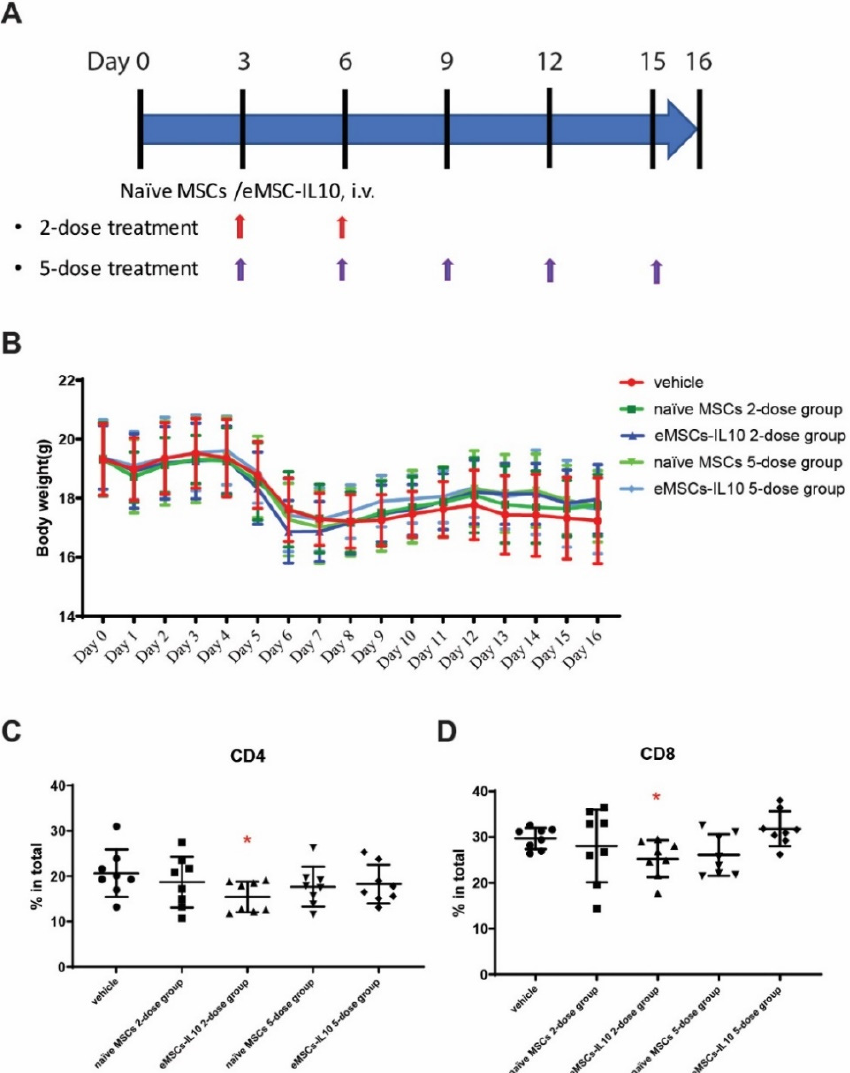
Figure 5. Engineered MSCs-IL10 significantly inhibited CD4+ and CD8+ T cells proliferation in the aGvHD mouse model. ( A ) Flow diagram of naïve MSCs and eMSCs-IL10 administration. In this experiment, two regimens were applied. For the two-dose treatment, MSCs were administered on Day 3 and Day 6. For the five-dose treatment, MSCs were administered every three days from Day 3 to Day 15 (total five doses). ( B ) Body weight of GvHD mice. There were no significant differences in body weight change among the groups. All the mice started to drop in body weight by Day 5, confirming the successful induction of GvHD. ( C , D ) Donor T cell infiltration in the host spleen. Donor CD4+ T cells ( C ) and donor CD8+ T cells ( D ) were significantly reduced in eMSCs-IL10 2-dose group on Day 17. Data expressed as mean ± SD, * p < 0.05.